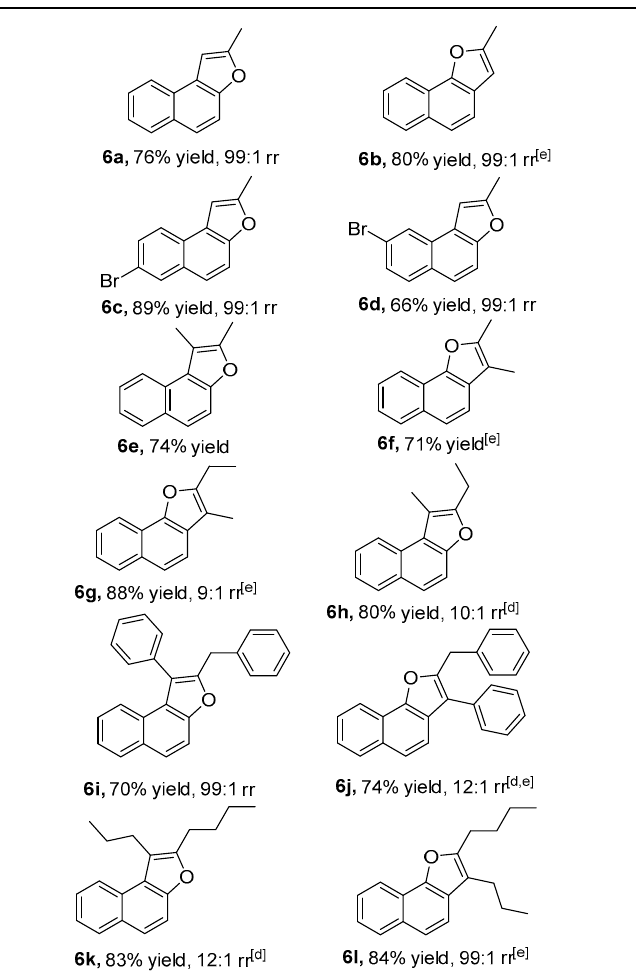
Table 3. Reaction of naphthols with different cyclic α -haloketones a, b